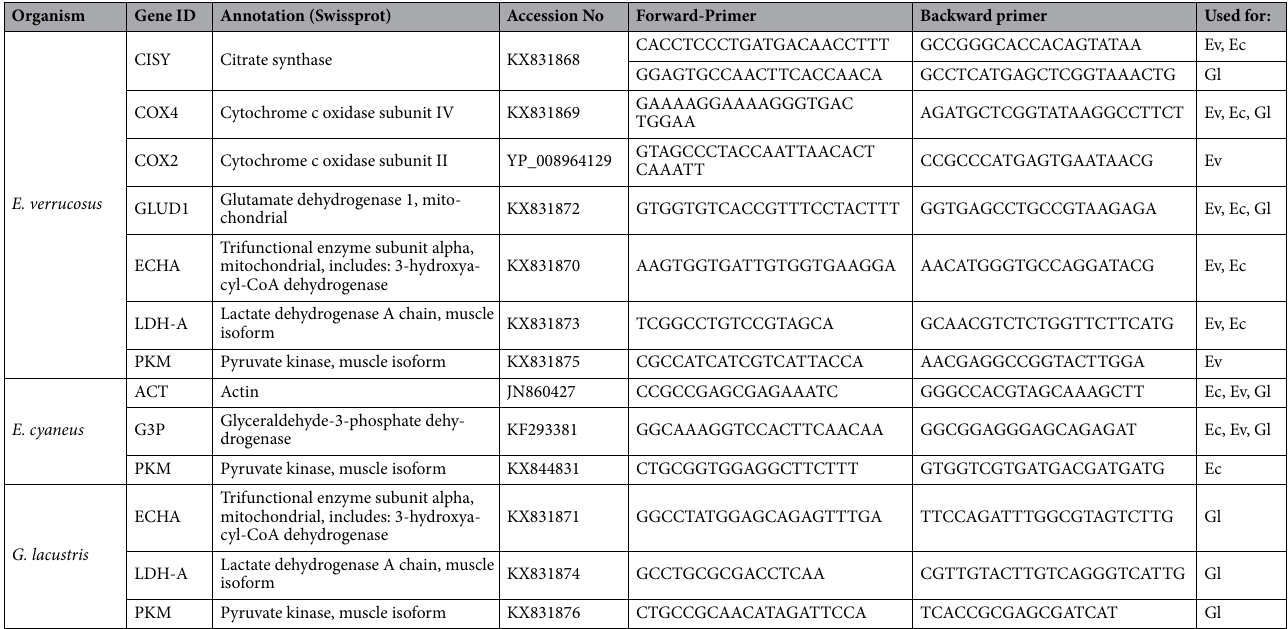
Table 1. Genes and primer sequences for real-time PCR. The primer pairs were derived from the genes of interest from the respective species and used after validation (see material and methods) for RT-PCR for the respective organism: E. verrucosus (Ev), E. cyaneus (Ec), and G. lacustris